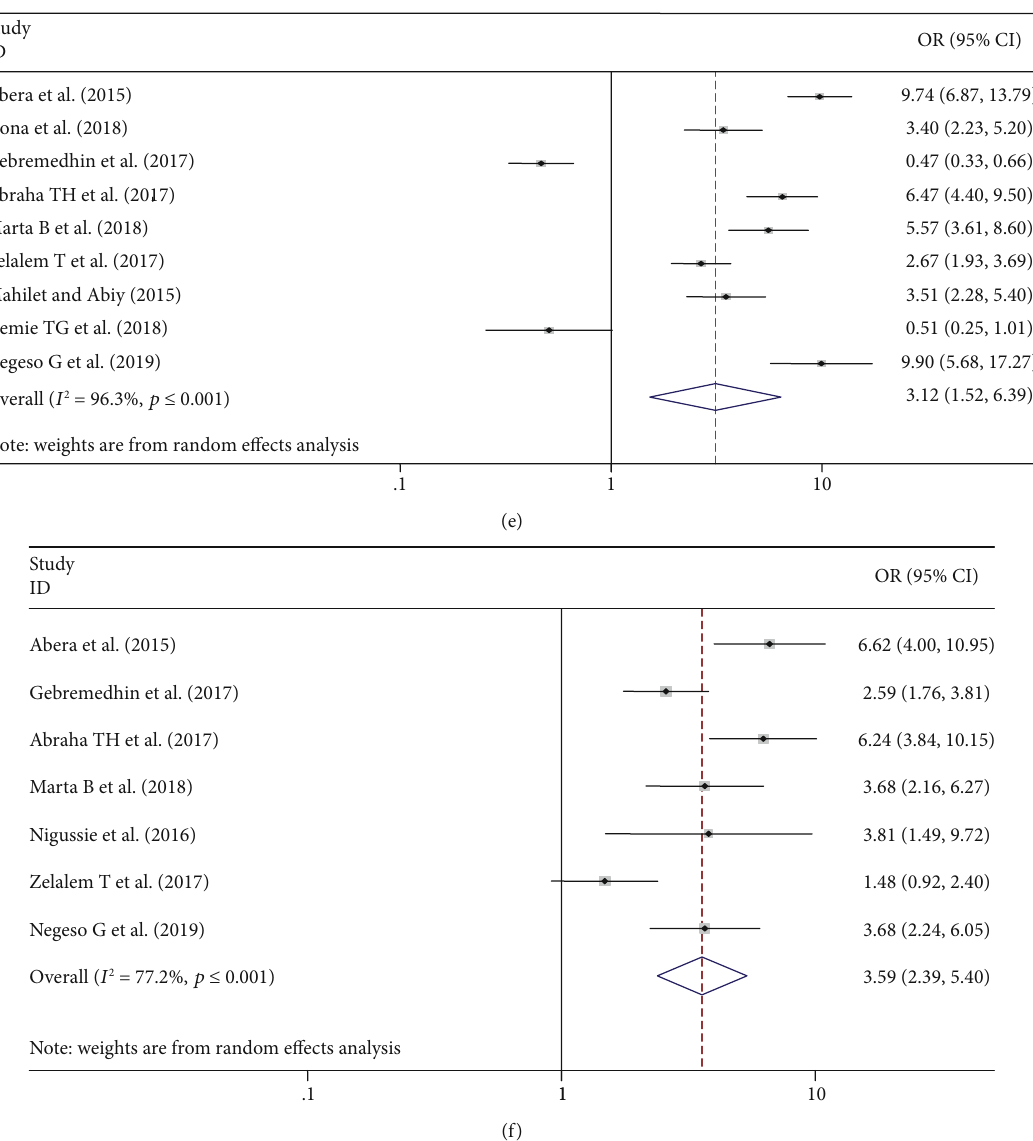
Figure 5: Forest plot depicting pooled odds ratio (log scale) of the associations between postpartum contraceptive use and its alleged determinants: (a) ANC, (b) resumed sexual activity, (c) PNC, (d) mothers ’ educational level, (e) menses resumption, and (f) duration after